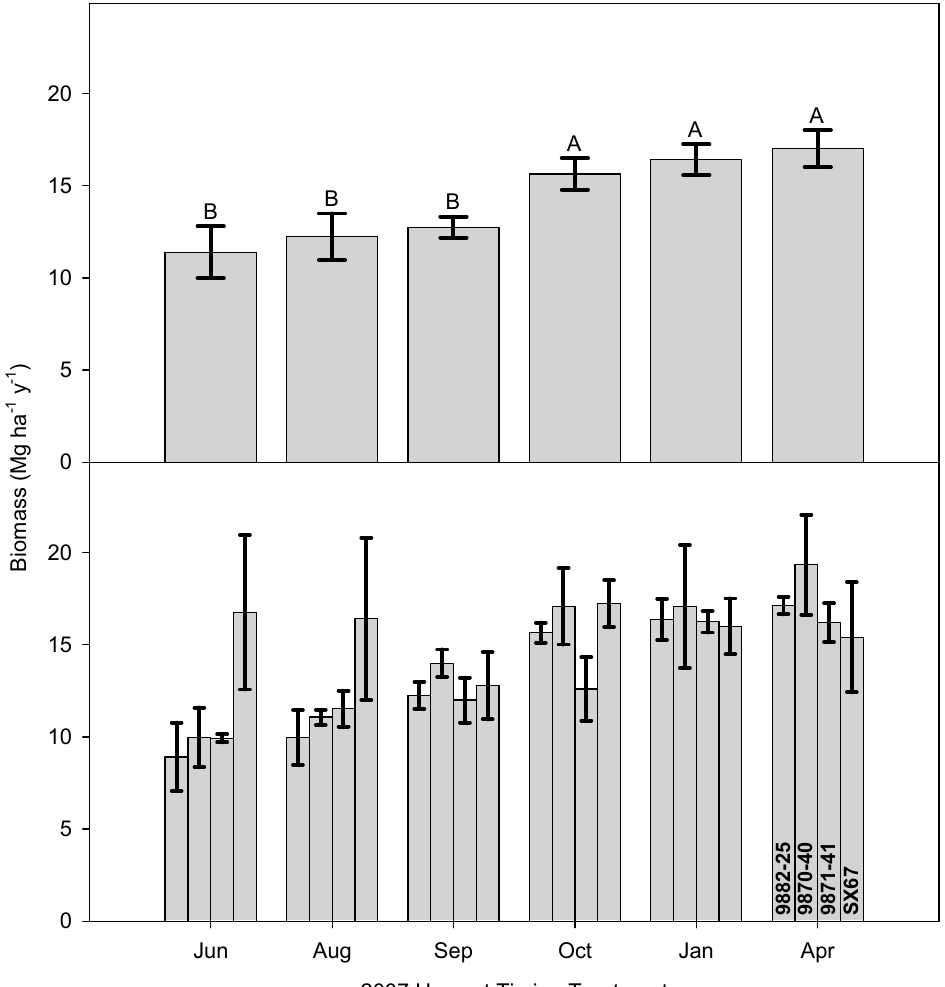
Figure 6. ( Top ) Mean and standard error of annual yield for the leaf-off, second rotation harvest in December 2011 within the time-of-harvest treatments (ToH) areas. Biomass amounts with shared letters are not significantly different. Error bars indicate the standard error. ( Bottom ) Sets of bars showing stem and foliage biomass for individual cultivars as labeled on the rightmost group.